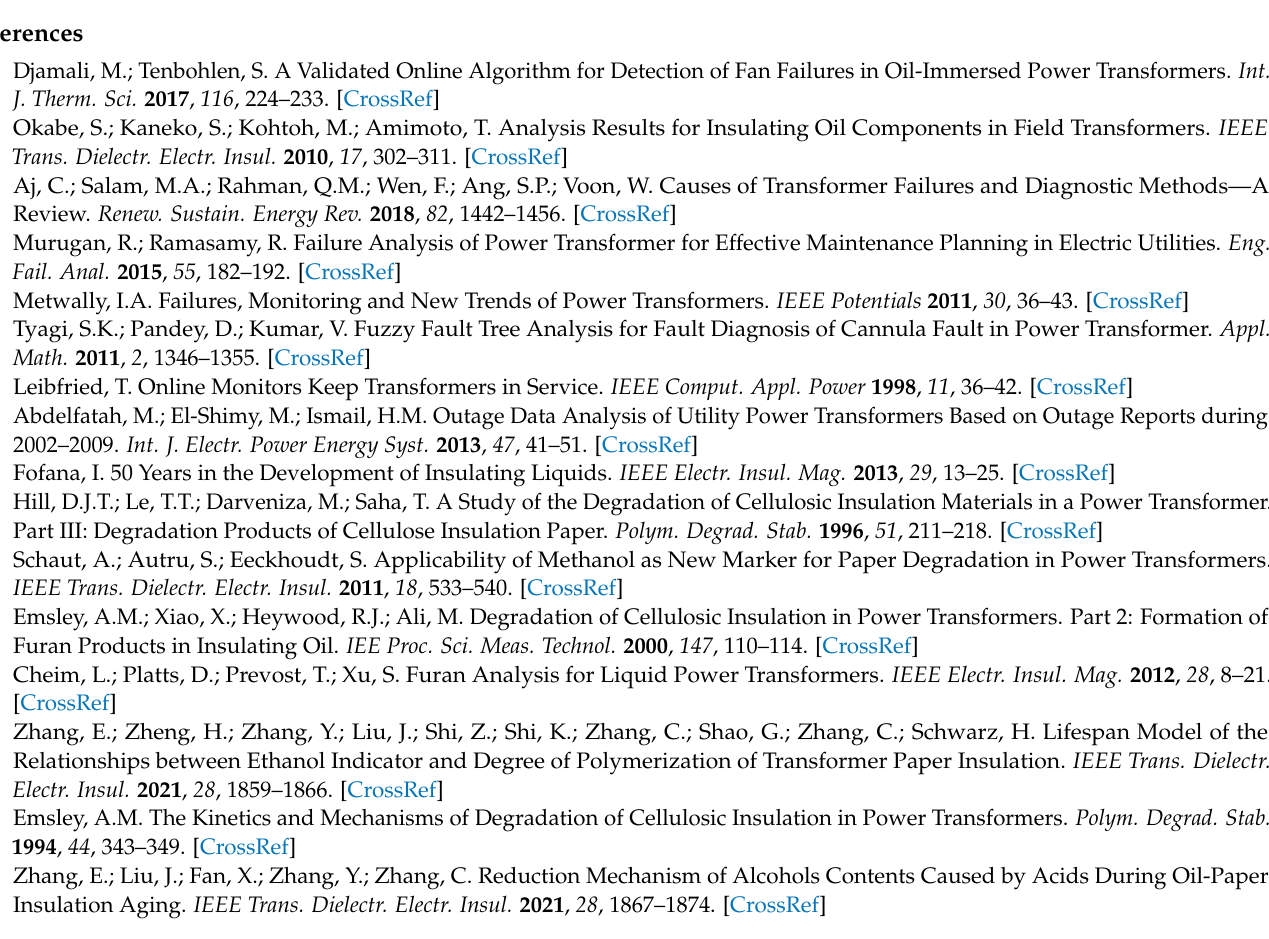
EF value; Figure S3. Schematic diagram for the CT process between ZnO, AgNWs, and the probe molecules; Figure S4. (a) SERS map of R6G at 1649 cm − 1; and corresponding histograms (b) for the above mapping area; Figure S5. Original SERS spectra of different concentration acetone extracts (The inset shows the local magnification of 0.09 mg/g, 0.03 mg/g, 0.01 mg/g and 0.003 mg/g); Table S1. Evaluation parameters of PLS models with different spectral preprocessing